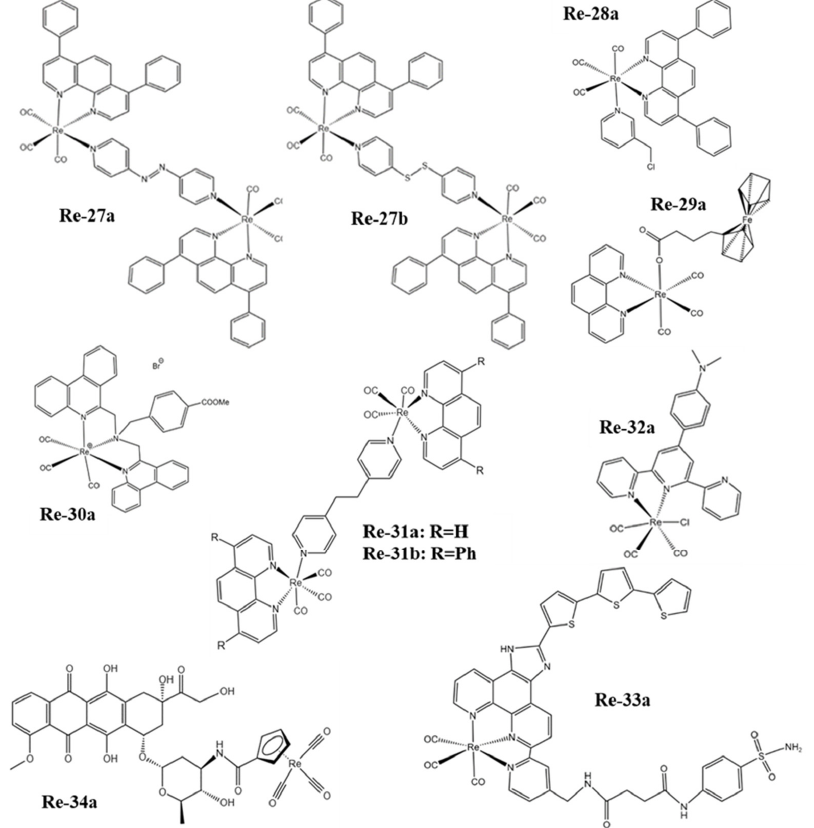
Figure 3. The structures of some Re complexes (Re-27a − Re-34a) involved in this review.